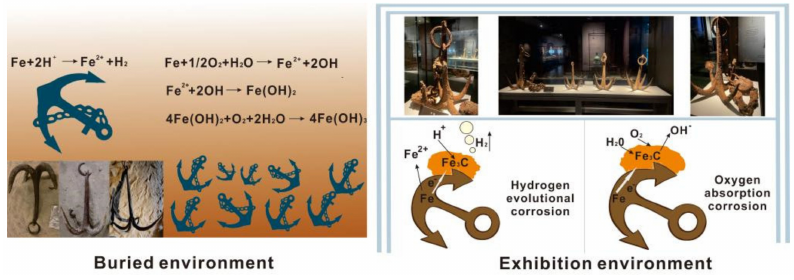
Figure 11. Corrosion mechanism of iron anchor in different